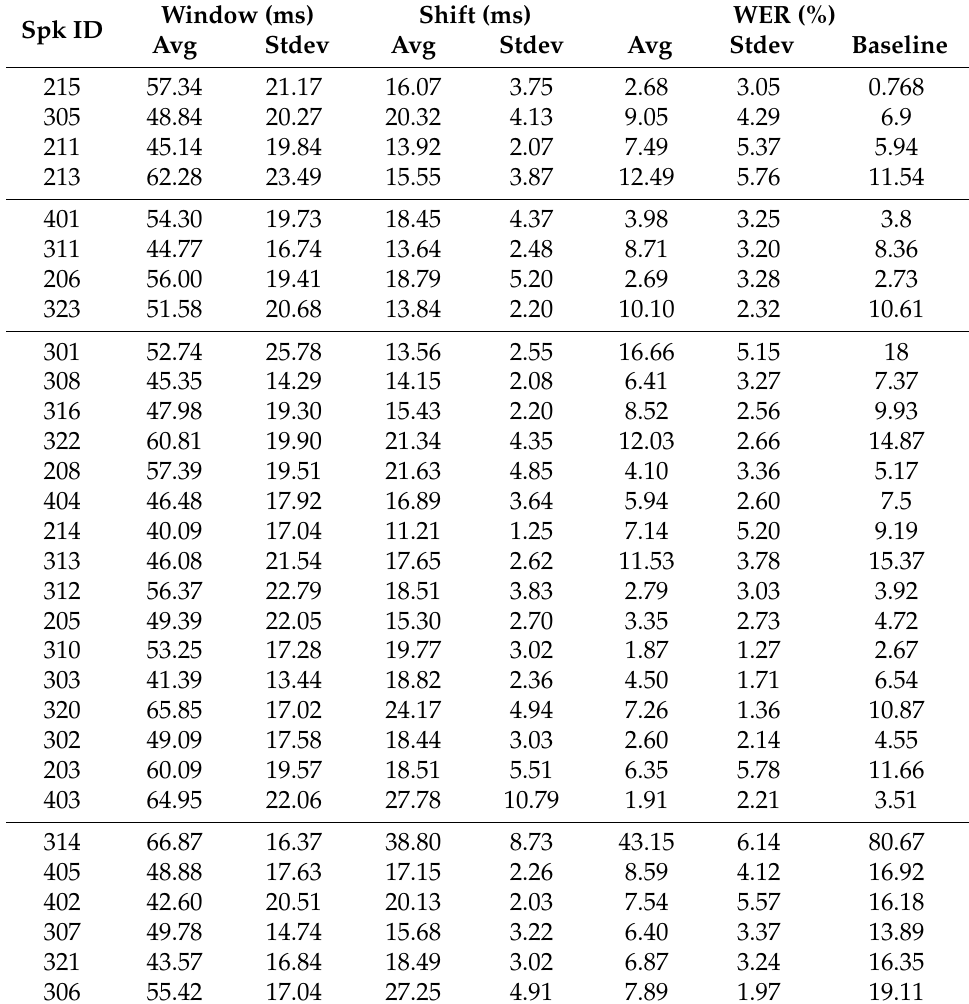
Table 2. Experiment results with IDEA database: speakers’ Optimal Regions and their WER compared with baseline (window and shift respectively 25 and 10